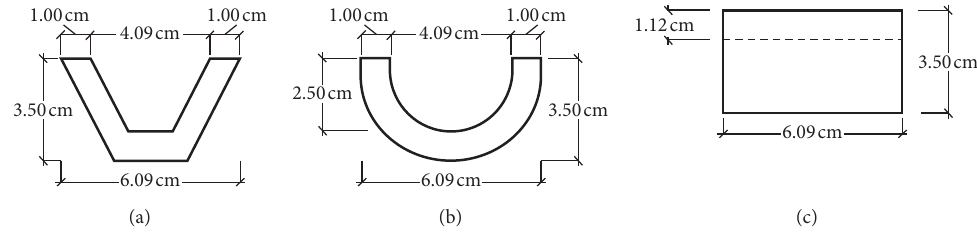
Figure 4: Top view of the plan and dimensions of the blocks: (a) trihedral, (b) semicircular, and (c) trapezoidal